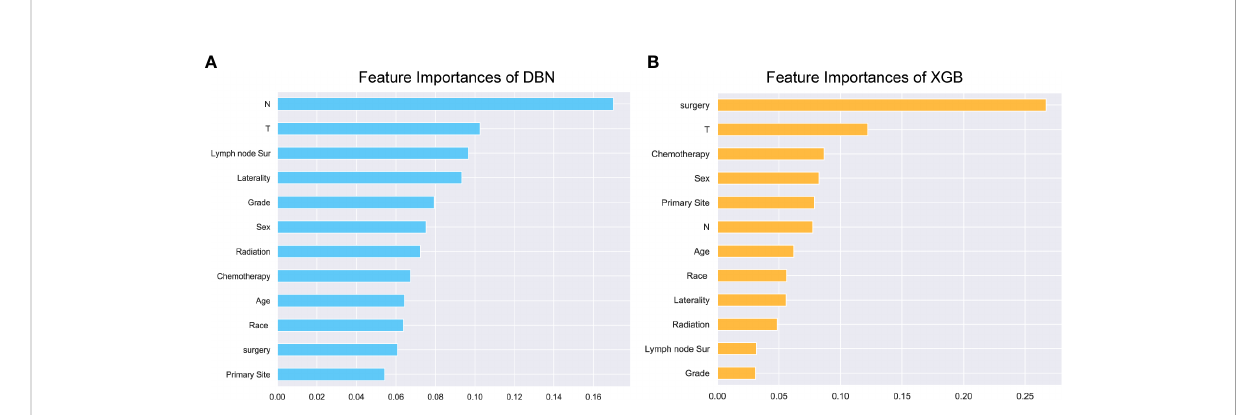
FIGURE 5 Feature importance. The top 12 feature importance results for the DBN (A) model and XGB (B) model trained on training set. DBN, Deep Belief Networks; XGB, XGBoost.